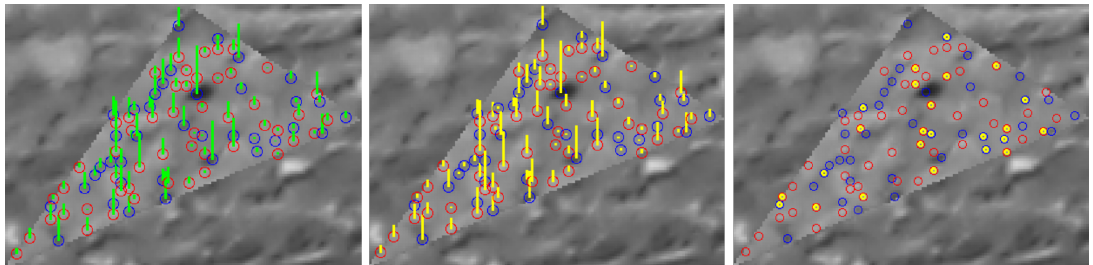
Figure 9. An example of Contrast Quality Score and contrast filter performance.